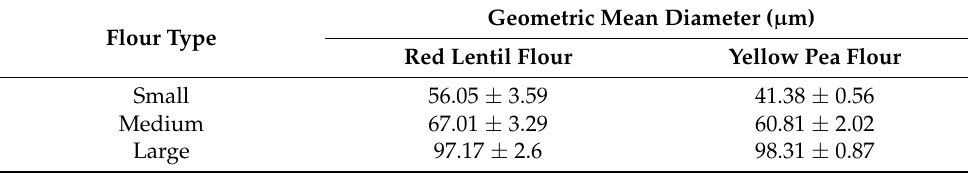
Table 3. Geometric mean diameter of red lentil and yellow pea